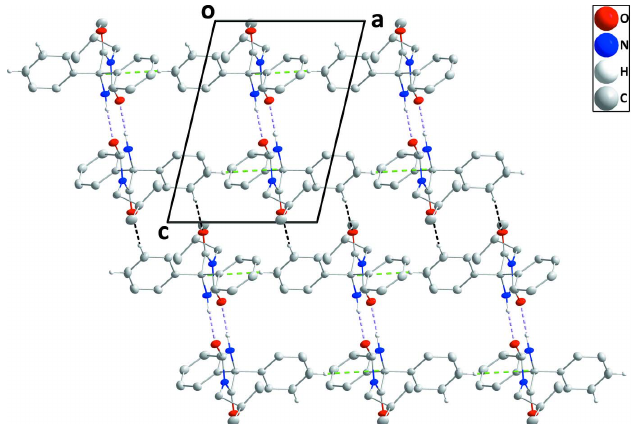
Figure 2 A portion of one layer viewed along the b -axis direction with N—H (cid:2)(cid:2)(cid:2) O and C—H (cid:2)(cid:2)(cid:2) O hydrogen bonds depicted, respectively, by violet and black dashed lines. C—H (cid:2)(cid:2)(cid:2) (cid:2) (ring) interactions are depicted by green dashed lines and non-interacting hydrogen atoms are omitted for clarity.